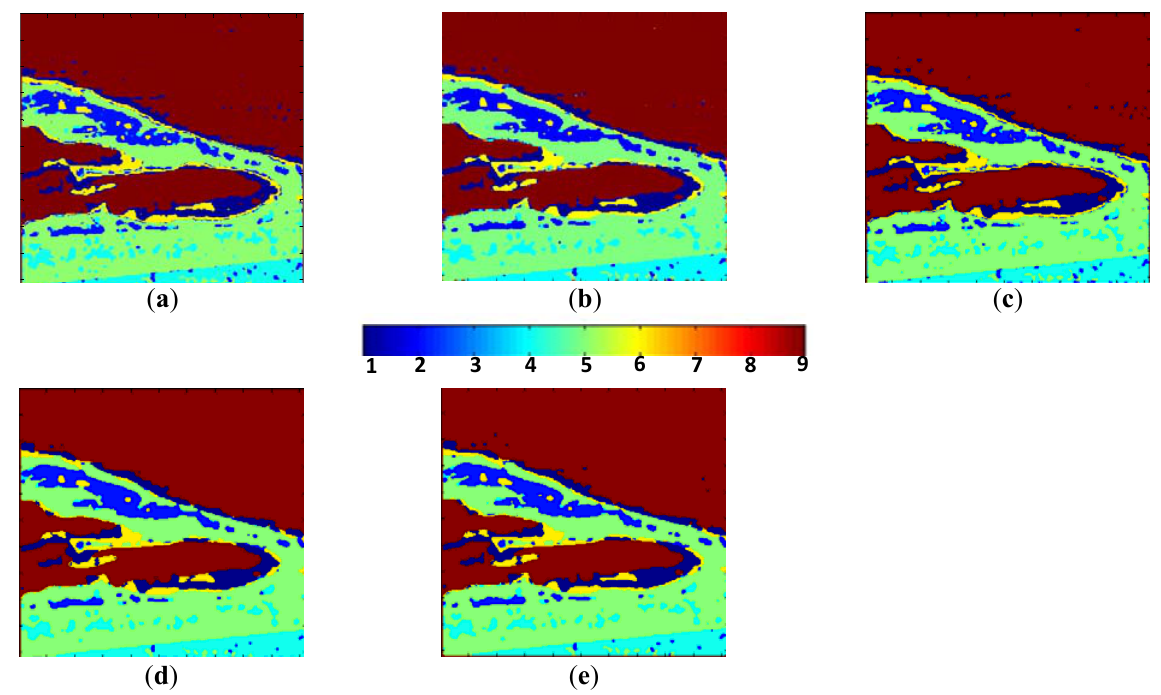
Table 4. Averaged Cluster Separability values ( R ), Homogeneities ( H ) and CPU times for Wishart, HNN, DSA, ICM and MAJ for Baltic Sea Lakes (BSL) image.